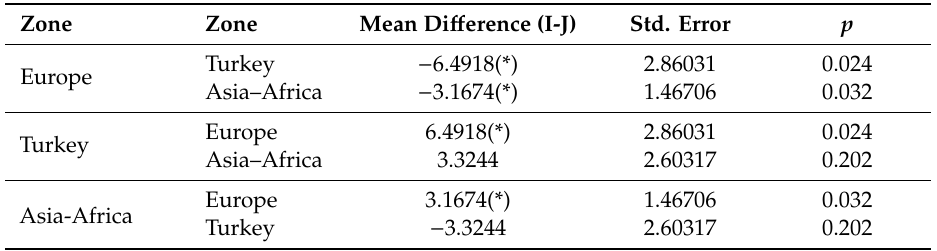
Table 12. The LSD test results regarding the Ethnocentrism Levels of students according to zone of